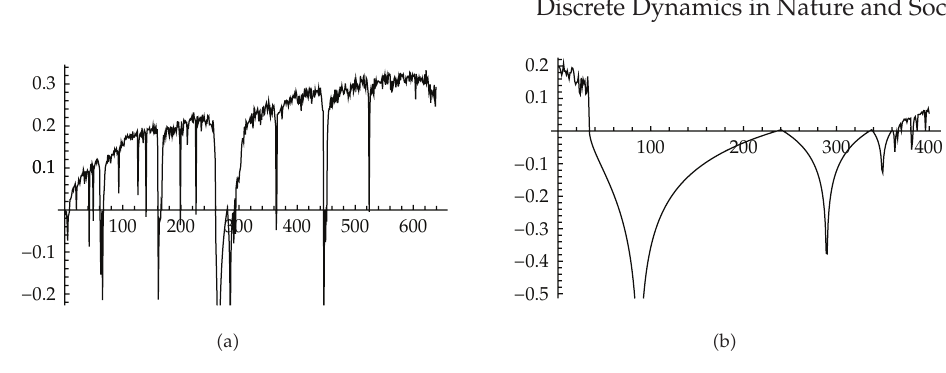
Figure 4: Estimation of the Lyapunov exponents for a (cid:6) 6 . 186 (cid:7) k/ 1000, 0 ≤ k < 640 (cid:4) a (cid:5) and 6 . 2115 (cid:7) k/ 100000, 0 ≤ k ≤ 400 (cid:4) b (cid:5)